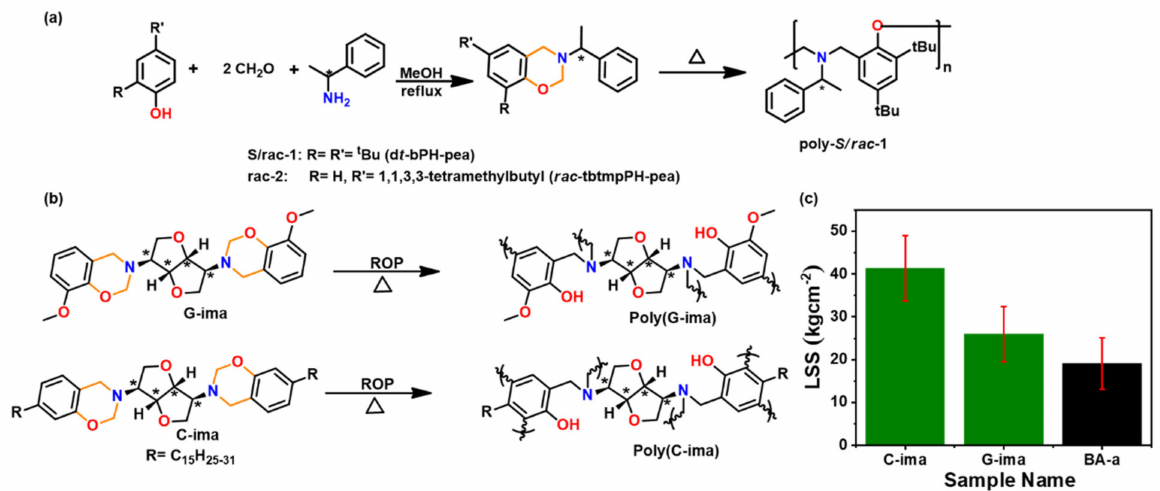
Figure 9. Synthesis and ROP of chiral Bz monomers ( a ) S - tbtmpPH-pea and rac -tbtmpPH-pea mono-oxazine [160], ( b ) G-ima and C-ima bis-oxazine [89] and ( c ) lap shear strength (LSS) values of C-ima, G-ima and BA-a benzoxazine based thermosets at room temperature [89]. Copyright 2019. Reproduced with permission from American Chemical